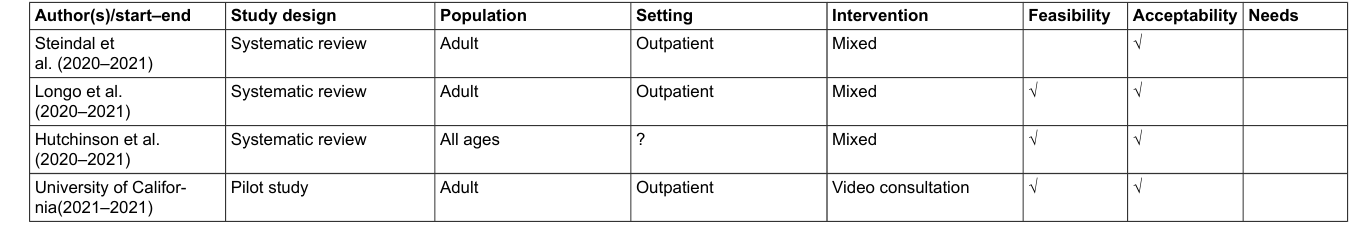
Table 2: Characteristics of the sources of evidence in the included ongoing studies